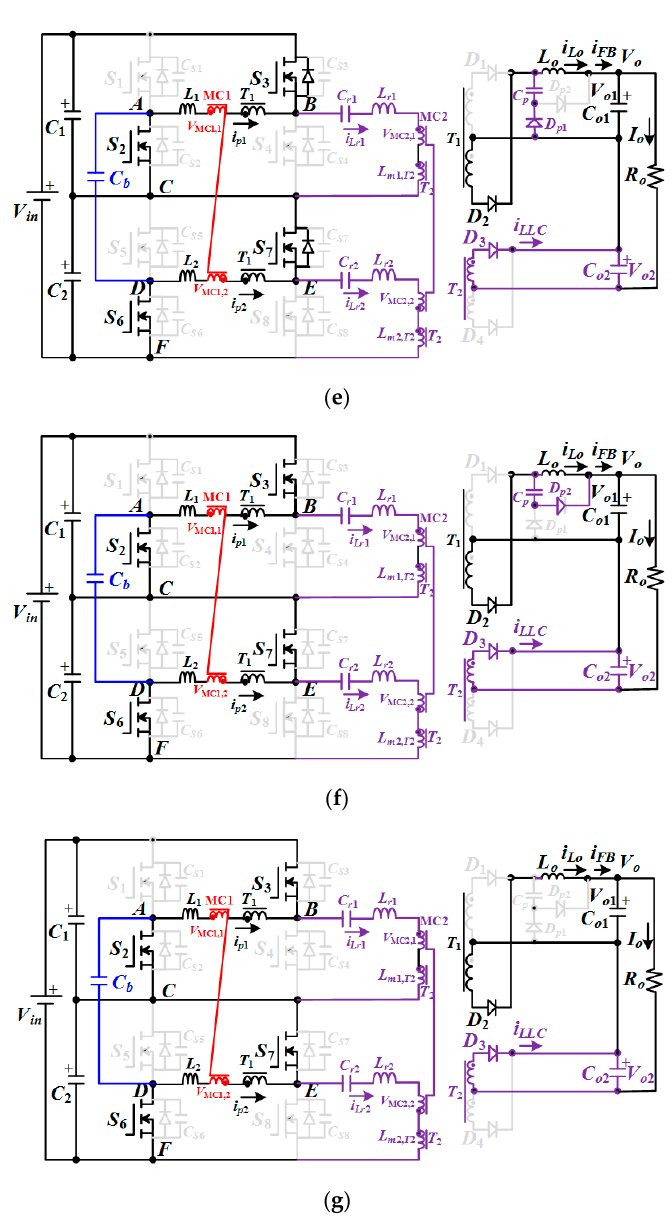
Figure 4. The related step circuits during one-half of switching period ( a ) step 1 circuit ( b ) step 2